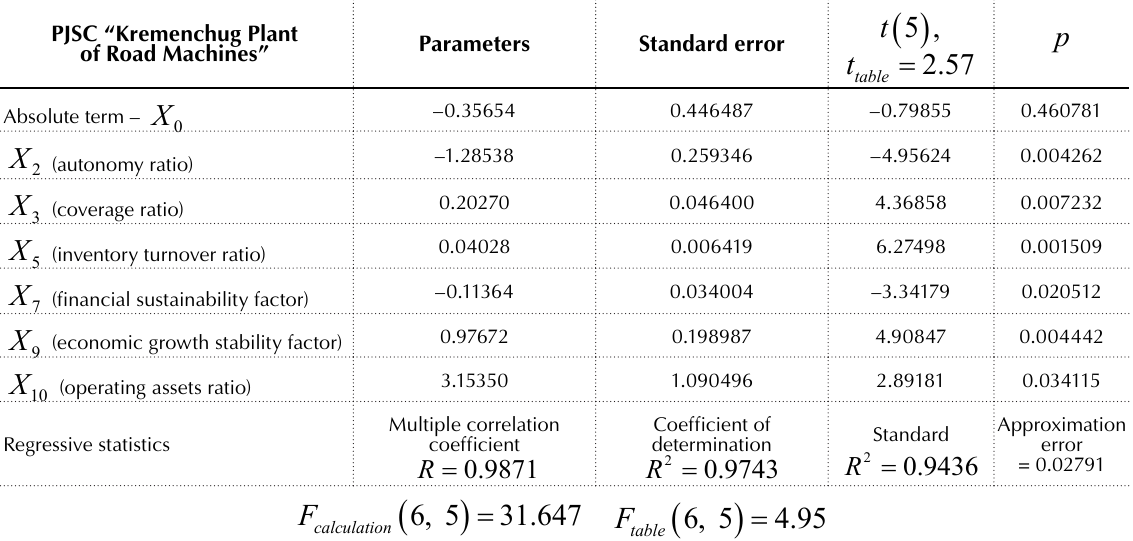
Table 1. Correlation and regression model of the internal capacity of technology transfer system development at PJSC “Kremenchug Plant of Road